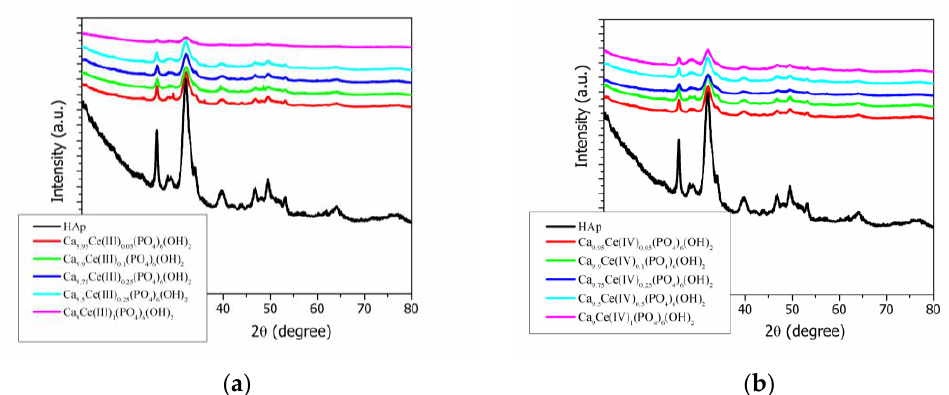
( a ) ( b ) Figure 2. ( a ) X-ray diffraction patterns of hydroxyapatite (HAp) and Ca 10 − xCe(III)x(PO4) 6 (OH) 2 ; ( b ) X-ray diffraction pat- Figure 2. ( a ) X-ray diffraction patterns of hydroxyapatite (Hap) and Ca 10 − xCe(III)x(PO4) 6 (OH) 2 ; ( b ) X-ray diffraction terns of hydroxyapatite (HAp) and Ca 10 − xCe(IV)x(PO4) 6 (OH) 2 . patterns of hydroxyapatite (Hap) and Ca 10 − xCe(IV)x(PO4) 6 (OH) 2 . Table 1. Calculated crystallite size (D), internal strains (S) values, and degree of crystallinity ( χ c ) of pure Hap, cerium (III)-doped hydroxyapatite and cerium (IV)-doped hydroxyapatite with various concentrations. Sample